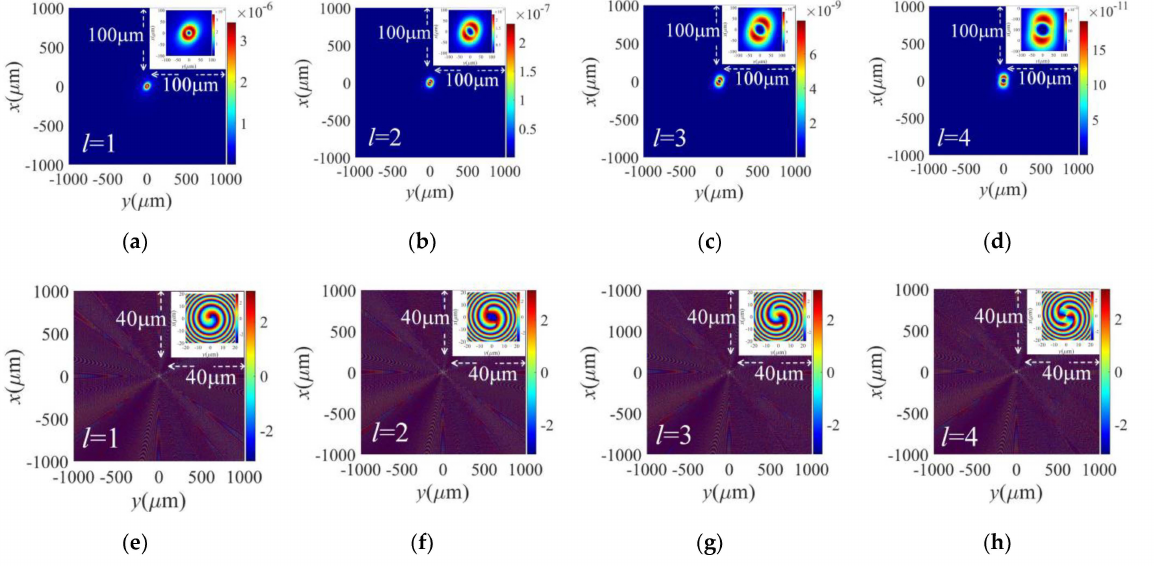
Figure 11. The same as in Figure 5, but the total field in the far region is